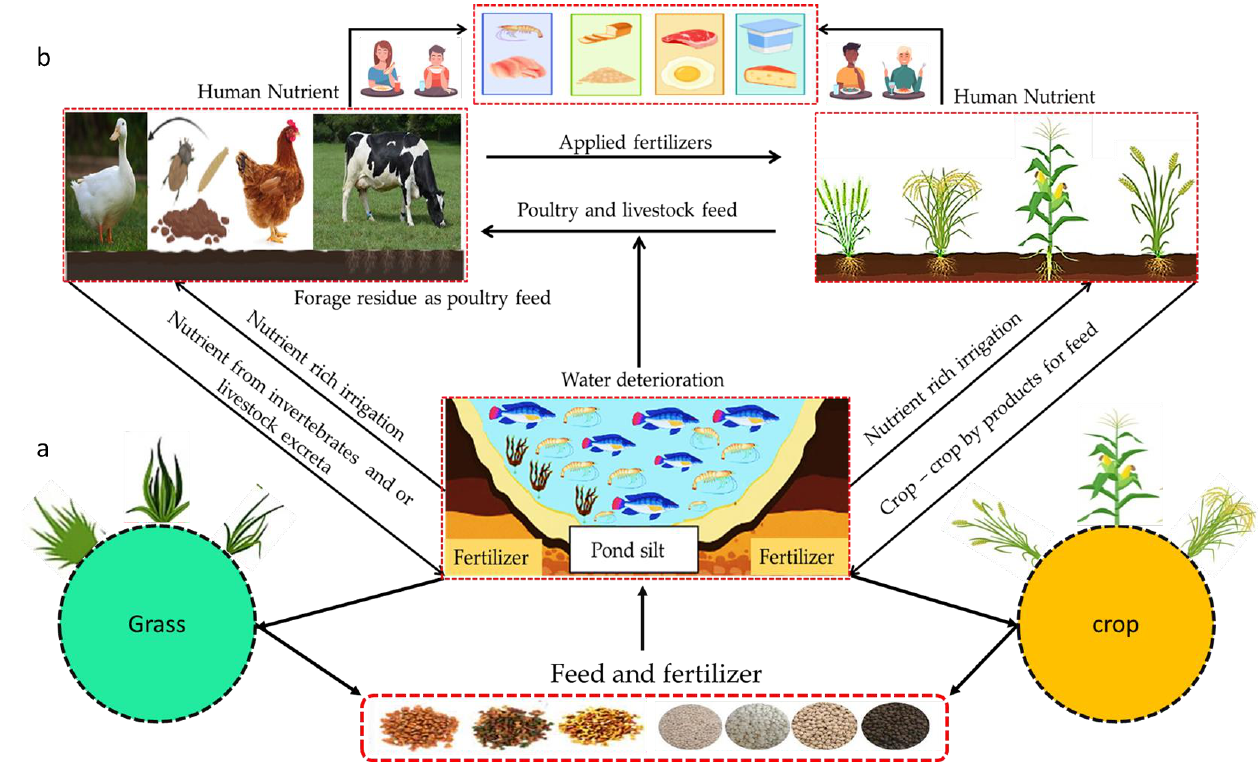
Figure 2. ( a ) Pond-dike cropping and ( b ) Fish – livestock – agriculture integration.